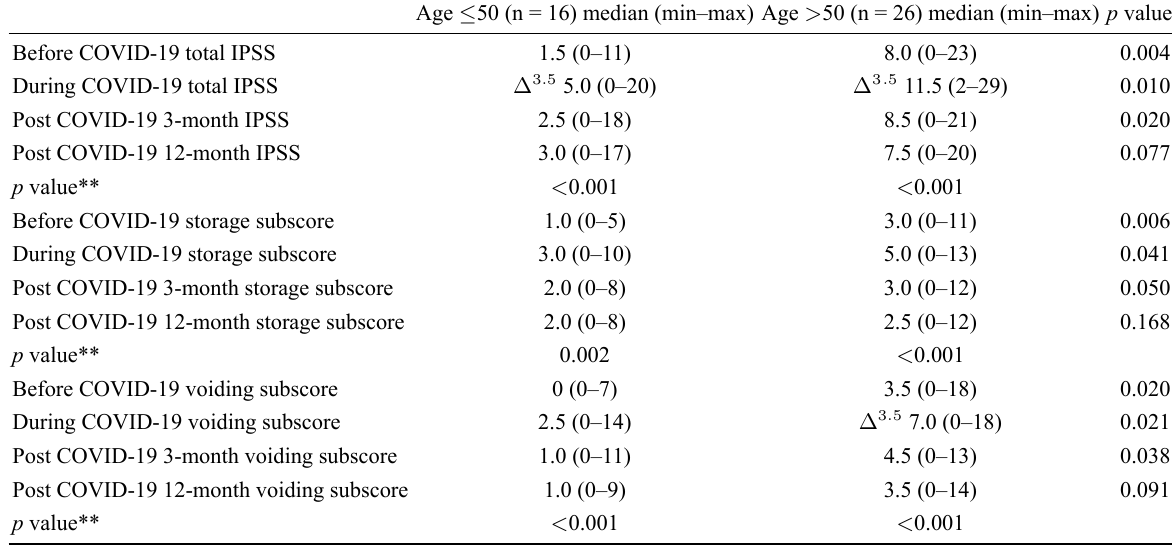
Fig. 1. Comparison of IPSS between pre-COVID, during COVID, and follow-up at 3-months and 12-months post-COVID diag- nosis. ∆ , change in IPSS of 3 points or more. Table 3. Change in IPSS before, during and after COVID-19 infection.